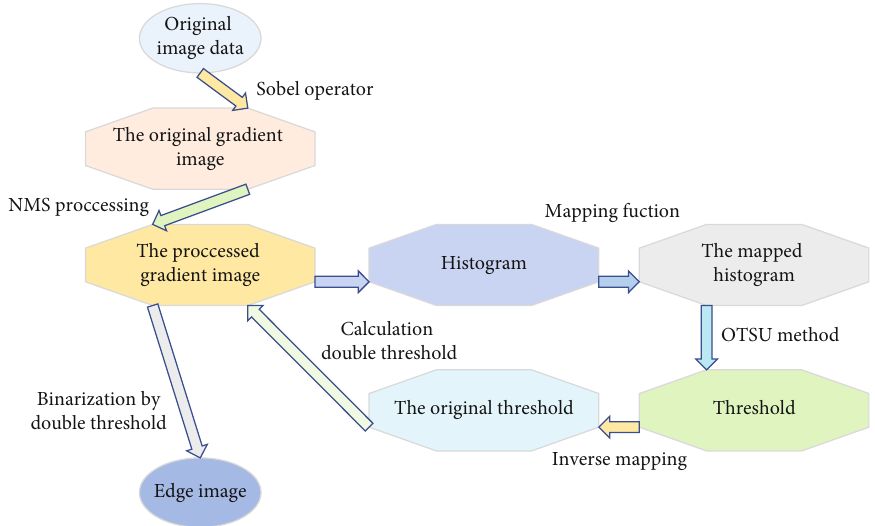
Figure 3: Image edge detection analysis fl